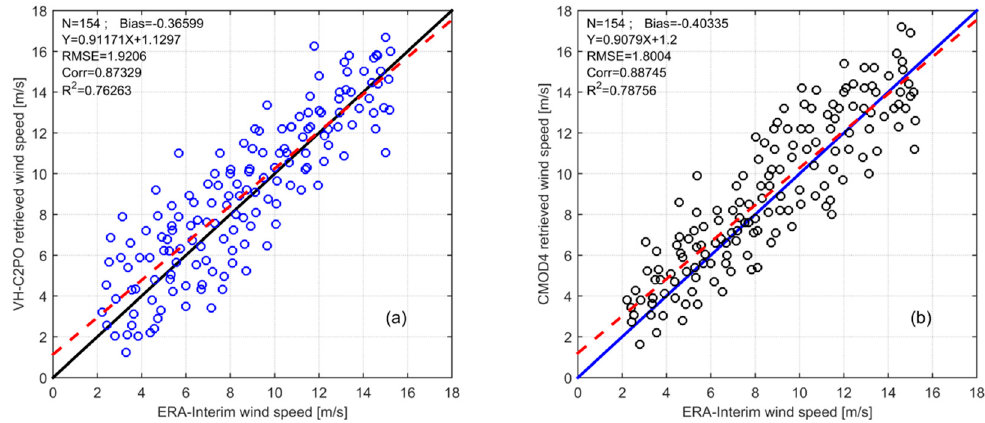
Figure 11. OSWSs retrieved from ( a ) VH-C2PO and ( b ) CMOD4+VV models from quad-polarized RADARSAT-2 images.